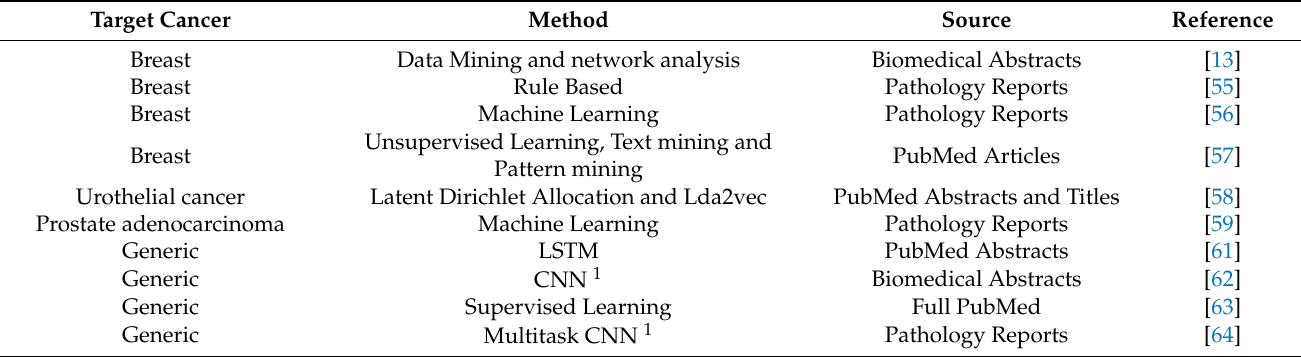
Table 2. Resume of the cited cancer text mining